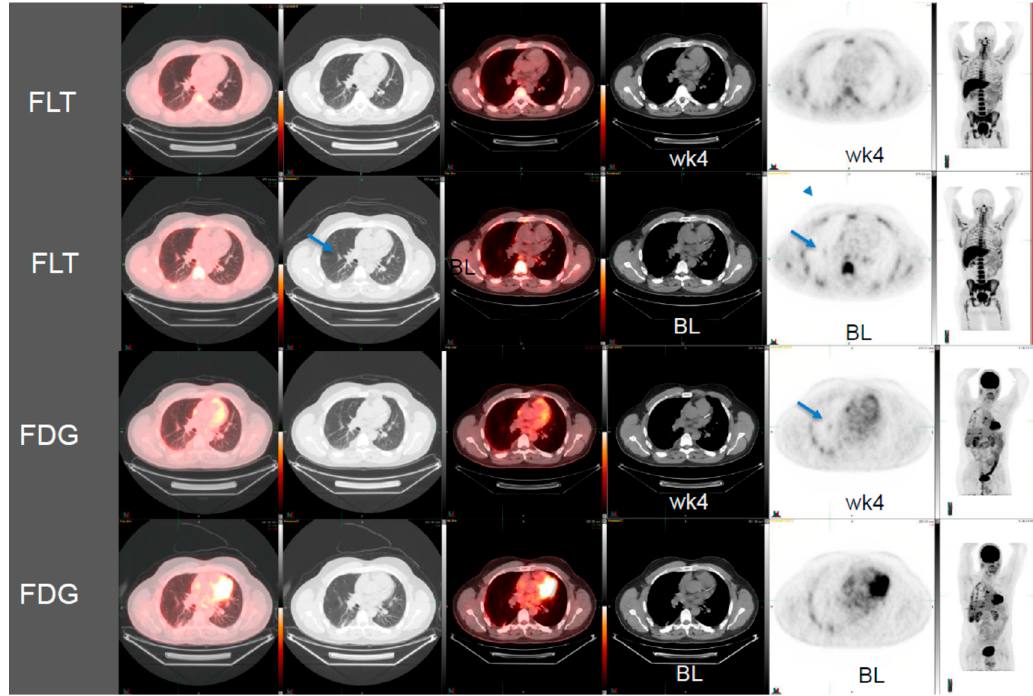
Figure 1. 3 ′ -deoxy-3 ′ [(18)F]-fluorothymidine ( 18 F-FLT) positron emission tomography/computed tomography (PET/CT) scans shows early response to c-MET inhibitor targeted therapy whereas the conventional CT scan and 2-deoxy-2-[18F]-fluoro-D-glucose ( 18 F-FDG) PET/CT images do not show any responses in this patient with small cell lung cancer (BL, baseline; wk4, at 4 weeks post therapy).Arrows show the location of tumors.